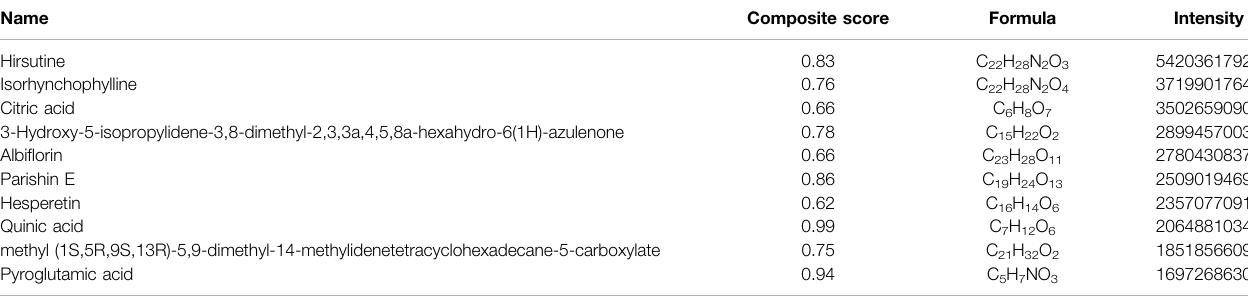
the low-QLZDD-dose group, p = 4.945 × 10 – 10 for the middle- QLZDD-dose group, p = 7.059 × 10 – 12 for the high-QLZDD-dose group, and p = 8.102 × 10 – 10 for the haloperidol group). Glu ( Figure 3E , p = 0.809), while signi fi cantly decreased GABA ( Figure 3F , p = 1.236 × 10 – 10 ). After 4 weeks of the drug administration, in comparison with the DA, the Glu, and the GABA of the model group, the DA ( p = 2.385 × 10 – 3 for the low-QLZDD-dose group, p = 1.487 × 10 – 3 for the middle-QLZDD- dose group, p = 7.479 × 10 – 5 for the high-QLZDD-dose group, and p = 3.713 × 10 – 4 for the haloperidol group) of drug-treated groups were signi fi cantly lower, the Glu of the QLZDD-treated groups was not signi fi cantly lower ( p = 0.966 for the low-QLZDD-dose group, p = 0.989 for the middle-QLZDD-dose group, p = 0.219 for the high- QLZDD-dose group, and p = 0.043 for the haloperidol group), and the GABA of drug-treated groups were signi fi cantly higher ( p = 1.132 × 10 – 6 for the low-QLZDD-dose group, p = 2.423 × 10 – 8 for the middle-QLZDD-dose group, p = 1.391 × 10 – 8 for the high- QLZDD-dose group, and p = 1.085 × 10 – 7 for the haloperidol